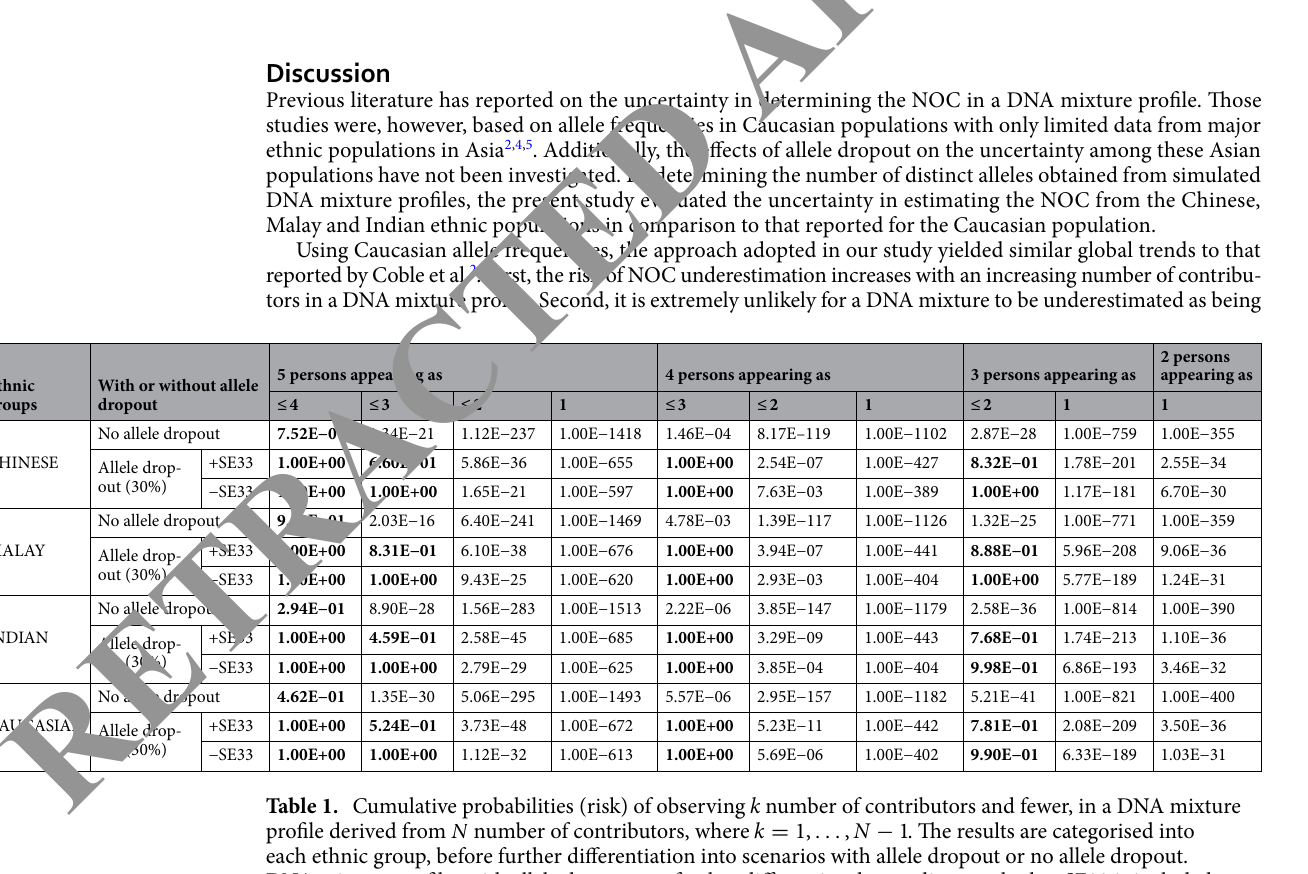
Figure 2. Heatmap of distinct allele counts generated from simulation with 30% overall allele dropout rate. The probabilities of observing different numbers of distinct allele counts obtained in a DNA mixture are displayed. The probabilities are categorised according to the different ethnic groups (in column) and the different number of contributors in the DNA mixture profiles (in rows). The 21 autosomal loci listed from top to bottom are identical to that in Fig. 1.